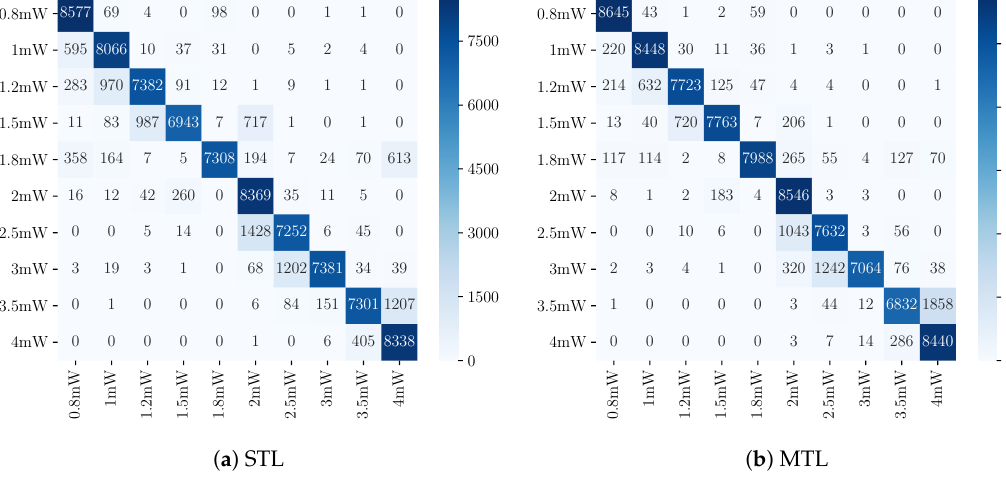
Figure 3. Confusion matrices of the predictions for Power Classification by AlexNet models with ( a ) STL and ( b )